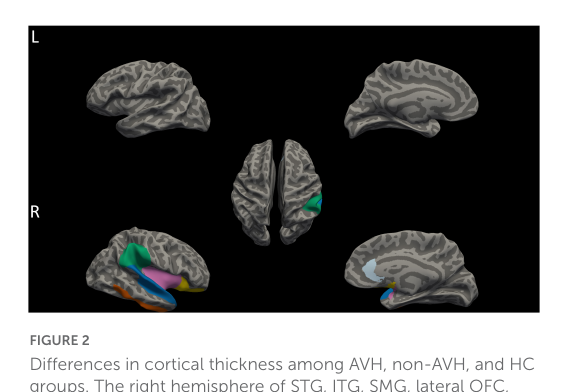
FIGURE2 Differences in cortical thickness among AVH, non-AVH, and HC groups. The right hemisphere of STG, ITG, SMG, lateral OFC, rACC, and INS (labeled in blue, orange, green, yellow, sky blue, and pink) showed significant differences in cortical thickness among three groups ( p < 0.05, corrected for multiple comparisons with LSD). L, left; R, Right.